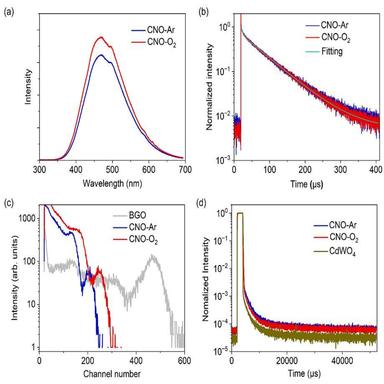
(a) X-ray luminescence spectra and (b) scintillation decay curves of CNO-Ar and CNO-O2, (c) Pulse height spectra of CNO-Ar, CNO-O2 and BGO, (d) X-ray induced afterglow curves of CNO-Ar, CNO-O2 and CWO.